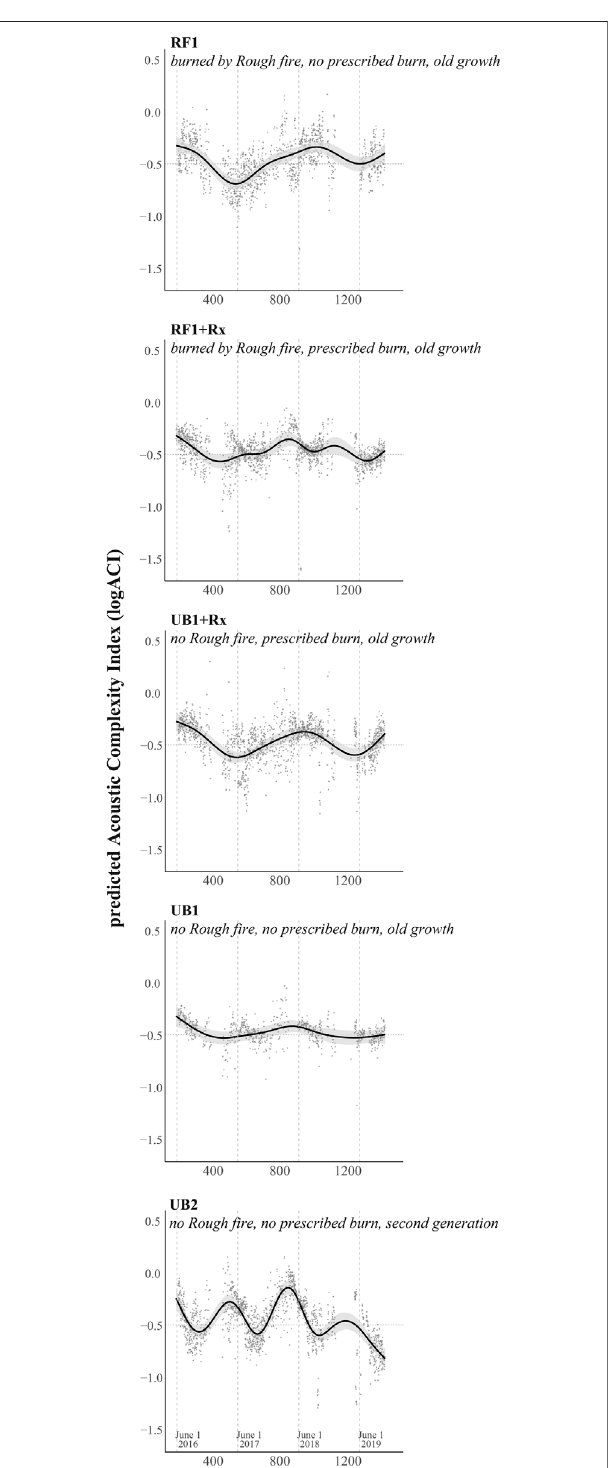
FIGURE 2 | Predicted relationships between ACI and days since Rough Fire was extinguished across fi re history sites over the four-year monitoring period. Plots are partial conditional dependence plots of the logarithm of predicted Acoustic Complexity Index, log10(ACI) and days since Rough Fire was extinguished. Vertical dashed lines reference 1st June across all years for reference to typical seasonal increase in ACI related to spring ecoacoustics activity dominated by avian